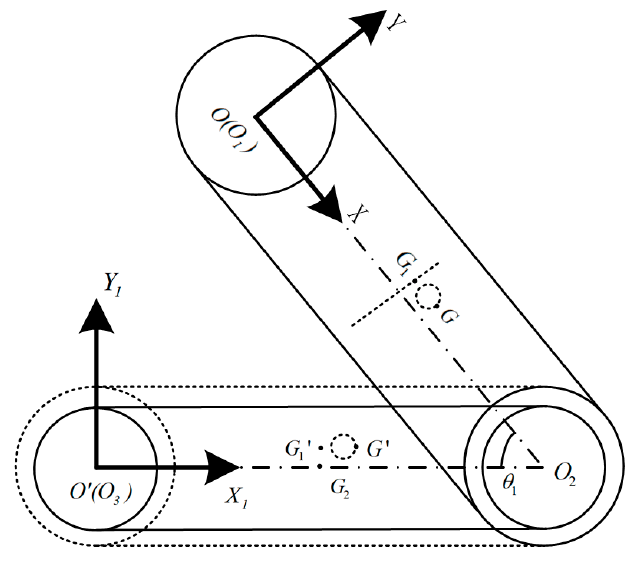
Figure 8. Lifting the state of the car body supported by the rocker arm. Figure 9 shows the diagram of the robot’s reverse obstacle crossing when the centroid of the robot happens to be at the key boundary of the step. According to Formula (7), the height of the step under the new coordinate system X 1 O (cid:48) Y 1 has the following relationship with the elevation angle α and included angle θ 1 :